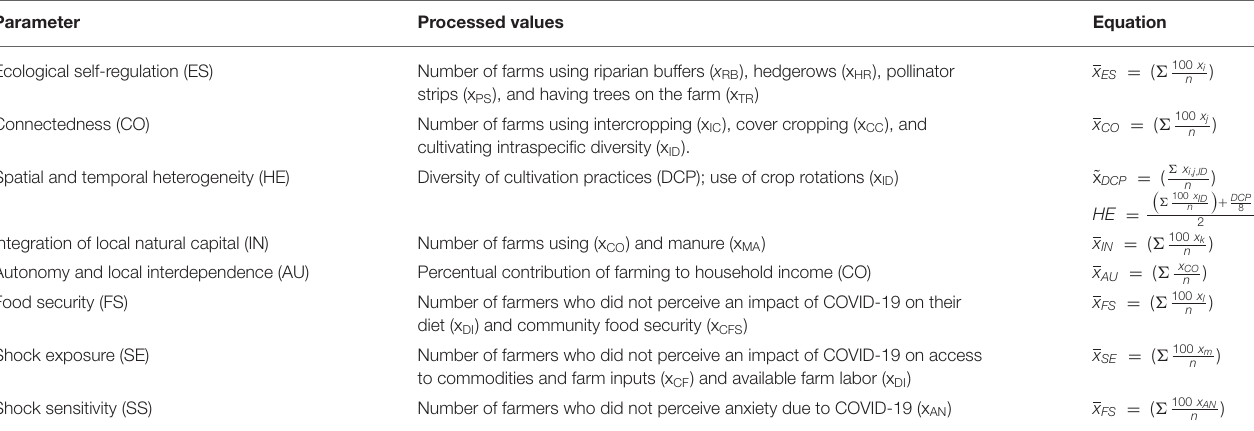
TABLE 3 | Equations, adapted from Cabell and Oelofse (2012), processed for the overall assessment of the resilience of the participating farms. Parameter Processed